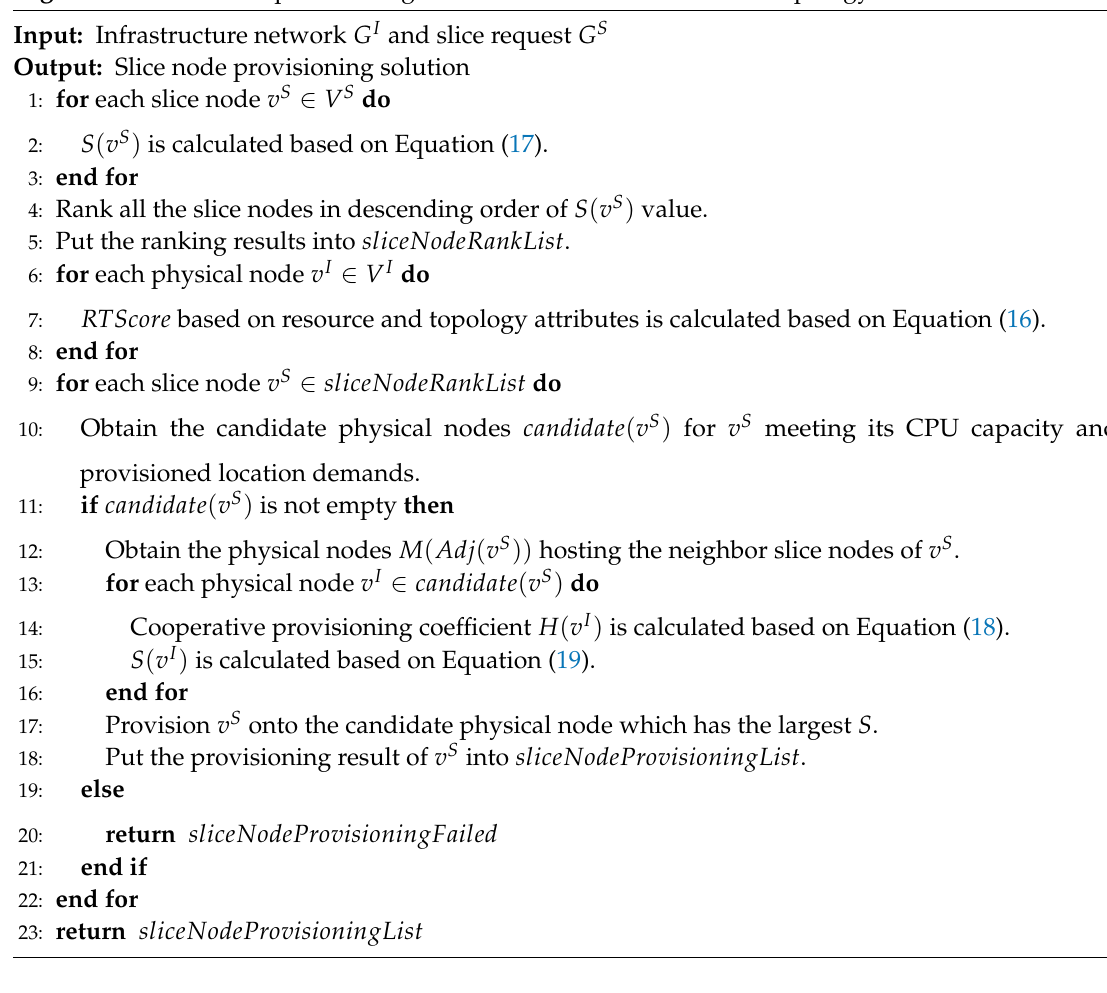
Algorithm 1 Slice node provisioning based on network resource and topology